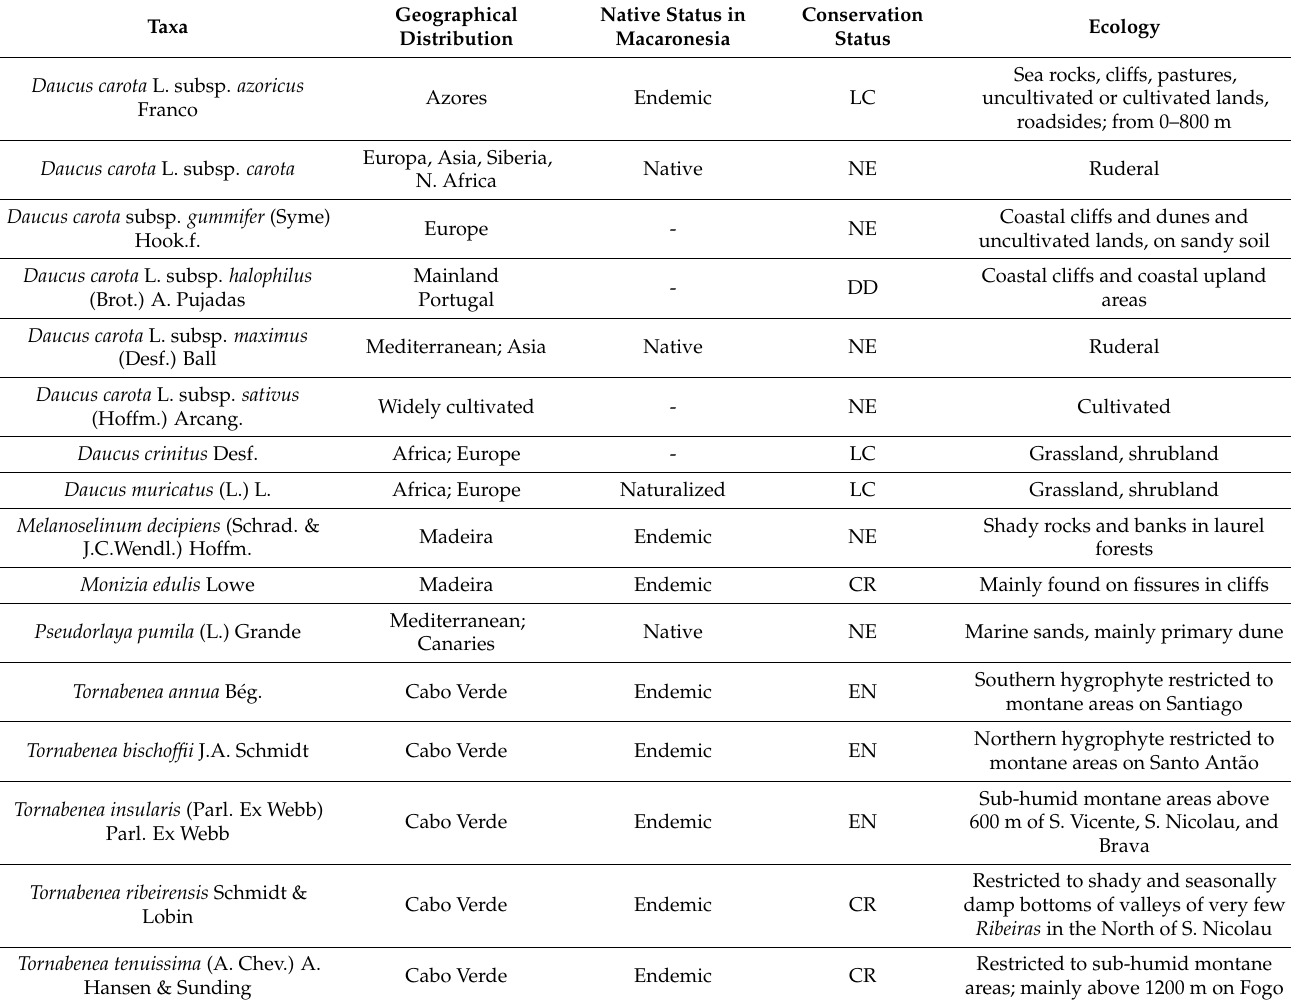
Table 1. Geographical distribution, native status in Macaronesia, conservation status (i.e., LC, least concern; NE, not evaluated; DD, data deficient; EN, endangered; and CR, critically endangered (see references in the Material and Methods section), and ecology of the study taxa of Daucinae subtribe in terms of bibliographic